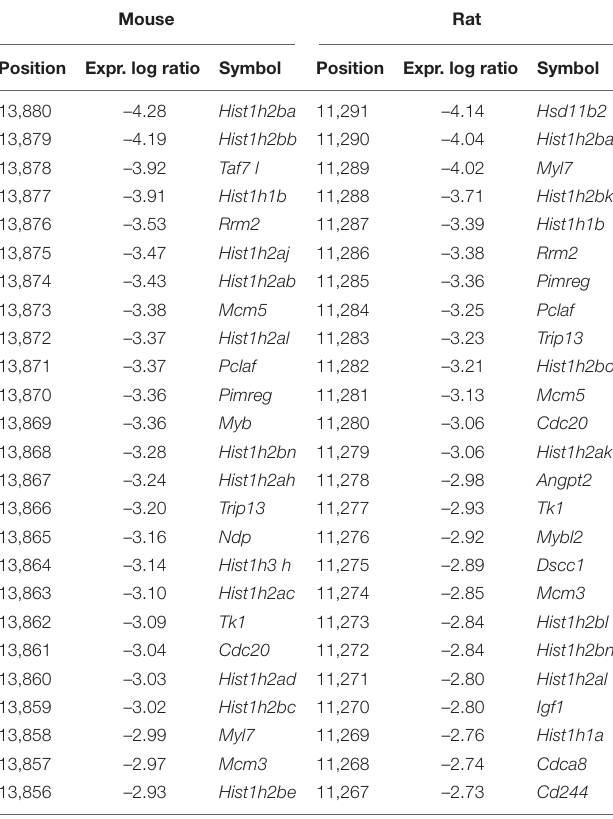
TABLE 1 | Top 25 significantly upregulated mouse and rat genes in response to neuronal differentiation of F11 cells. Mouse Rat Position Expr. log ratio Symbol